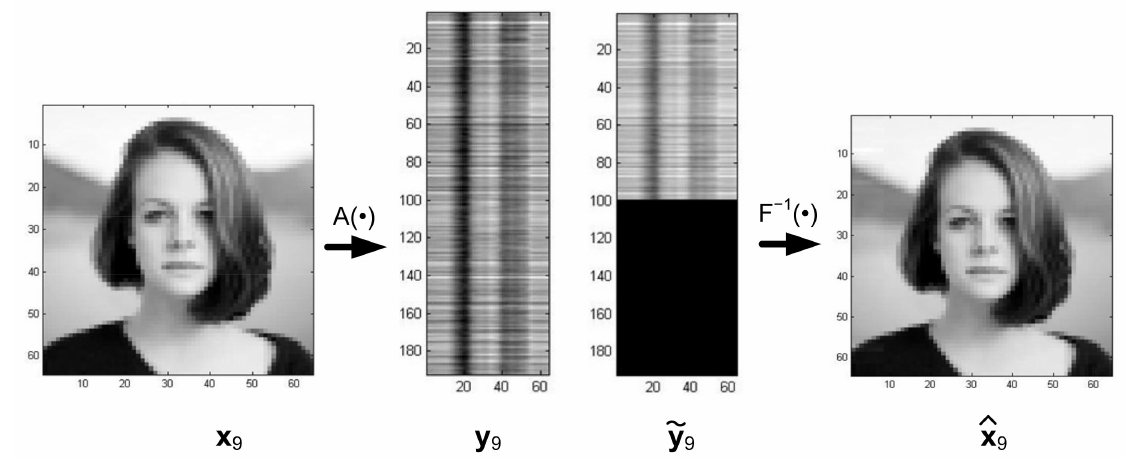
Figure 14. An exemplary reconstruction (F ( · )—system from Figure 13b).